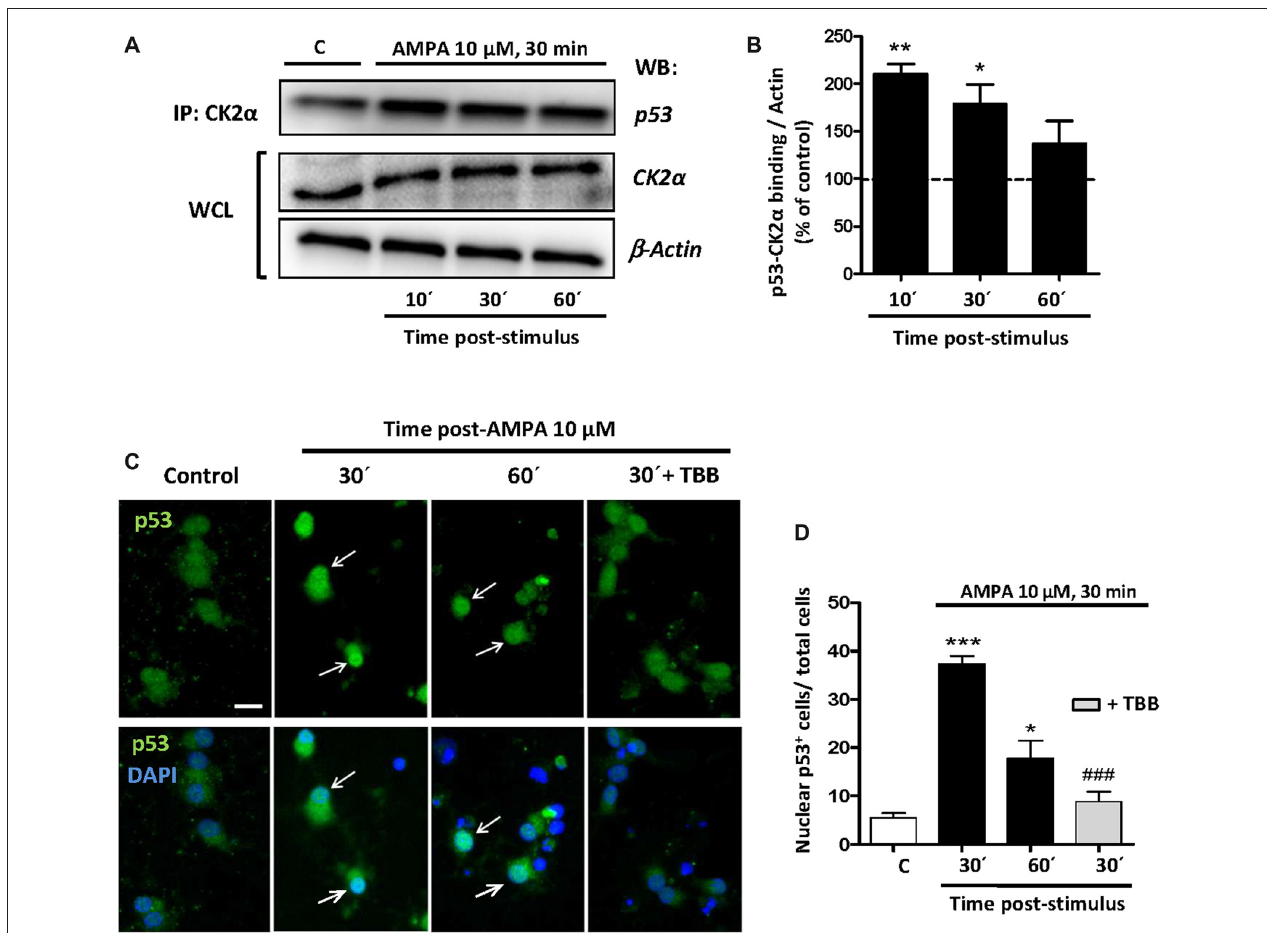
FIGURE 7 | CK2 directly interacts with p53 under conditions of AMPA-induced excitotoxicity in oligodendrocytes. (A) Oligodendrocytes in culture were subjected to excitotoxic insult and cell lysates were obtained at 10, 30 and 60 min after AMPA receptor activation. Co-immunoprecipitation assays were performed in the presence of rabbit polyclonal anti-CK2 α antibody (IP: CK2 α ) and the immunoprecipitates were analyzed by WB using a mouse anti-p53 antibody. CK2 α and β -actin were measured as internal loading controls in WCL. The image corresponds to one representative co-immunoprecipitation assay where it is observed that activation of AMPA receptors in oligodendrocytes provokes a direct interaction between CK2 and p53. (B) Quantification of p53-CK2 α binding after co-immunoprecipitation assay in the experimental conditions indicated ( n = 3; ∗ p < 0.05; ∗∗ p < 0.01 respect to control). (C) Immunofluorescence analysis of total p53 expression after AMPA receptors activation in absence or presence of CK2 inhibitor TBB. After AMPA treatment, oligodendrocytes were fixed, processed for immunofluorescence with an anti- total p53 antibody (p53 FL-393; green) and nuclei were stained with DAPI (blue). Images show that the increase in p53 activation and its translocation to the nuclei, examples indicated by arrows, was reduced by the CK2 inhibitor TBB. Scale bar, 10 µ m. (D) Quantification of the number of p53 nuclear events determined by counting the cells with p53 in DAPI-positive region as fraction of total cells present in each condition. Cell counts were performed on a minimum of 10 independent fields (30 fields/3 coverslips/treatment) of images captured with a 20 × objective, and all experimental conditions were always paired with corresponding internal controls ( ∗ p < 0.05; ∗∗∗ p < 0.001 respect to control; ### p < 0.001 respect to AMPA after 30